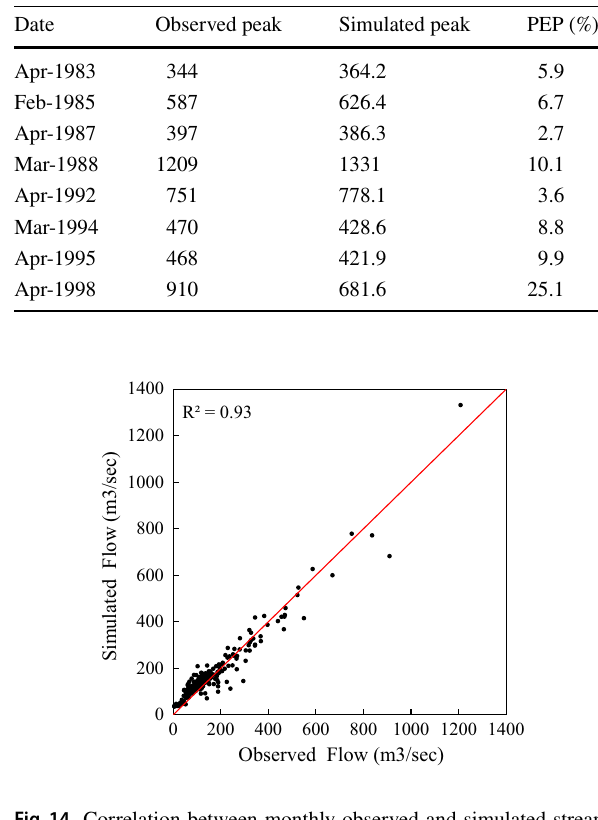
Fig. 14 Correlation between monthly observed and simulated stream flow measured during calibration